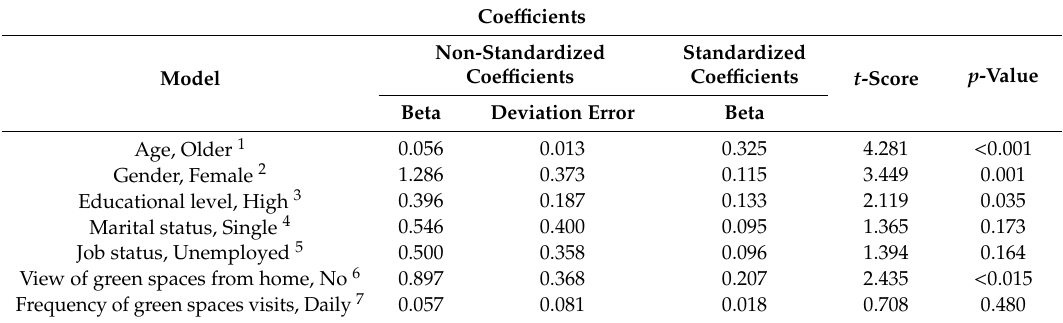
Table 3. Multiple linear regression between anxiety and sociodemographic variables, view of green spaces from home, and frequency of green space visits in Carmona, Spain.